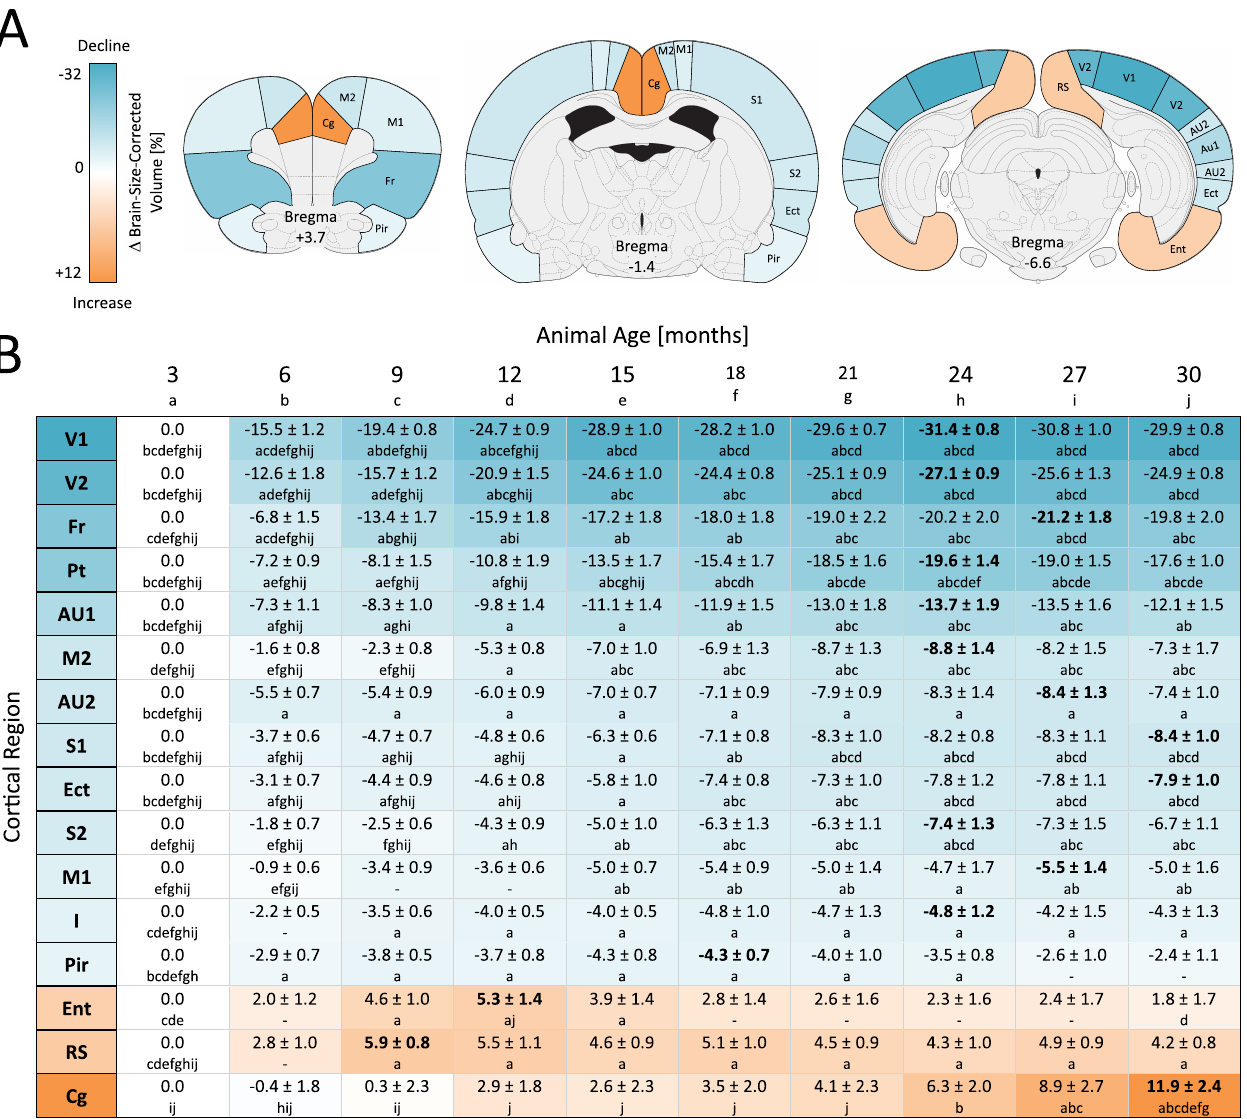
Figure 2. ROI-based analysis of cortical morphological changes in male RccHan:WIST rats across their lifetime. ( A ) The examined cortical regions are exemplarily superimposed on coronal sections from the Paxinos Atlas (V1/V2: primary/secondary visual, AU1/AU: primary/secondary auditory, S1/S2: primary/secondary somatosensory, Pir: piriform, M1/M2: primary/secondary motor, Fr: frontal, Pt: parietal, Ect: ectorhinal, I: insular, Ent: entorhinal, RS: retrosplenial, Cg: cingu- late). The definitions of cortical regions are shown in Supplementary Table S1B. ( B ) Percentage changes in brain-size-corrected regional volumes are shown in ascending order as mean ± SEM (hemispheric averages, maxima in bold). Blue colors show regions for which the volume was changed below (henceforth termed “shrinkage”), and red colors show regions for which the volume was changed above (henceforth termed “growth”) the rate of whole brain volume change. A total of n = 13 rats were included in the study. The absolute measures, brain-size-corrected volumes, their estimated percentage changes, and the statistics of one-way RM ANOVA with Tukey HSD are shown in Supplementary Table S1C. The results of the post hoc test are shown as age-coded letters, representing a significance level of p <